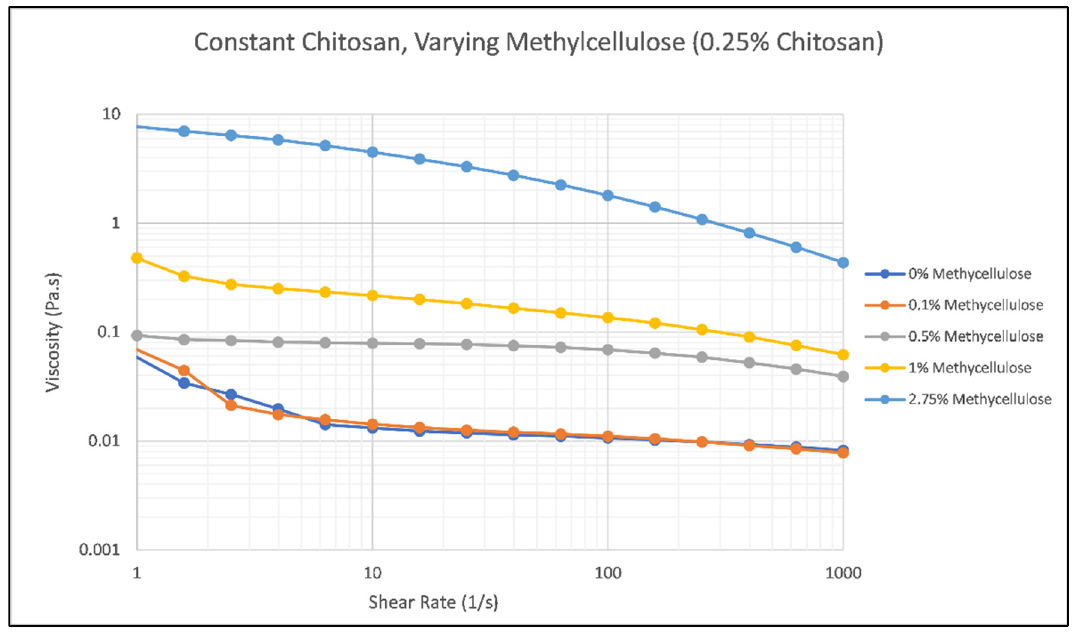
Figure 2. Effect of Methylcellulose Concentration on the viscosity of Samples 1 (blue), 2 (orange), 3 (gray), 4 (yellow), and 5 (green) as the shear rate increases from 1 to 1000 s − 1 .